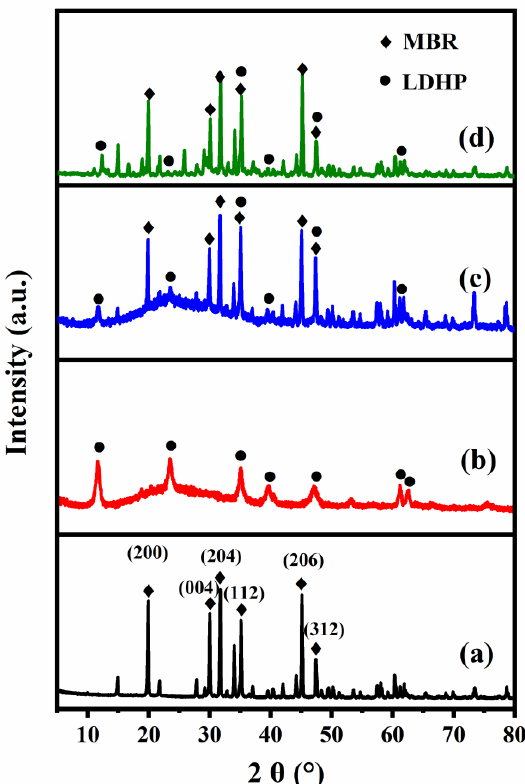
Figure 1. The XRD patterns for MBR ( a ), LDHP ( b ), MBR@LDHP ( c ), and MBR@LDHP-APES ( d ). 207